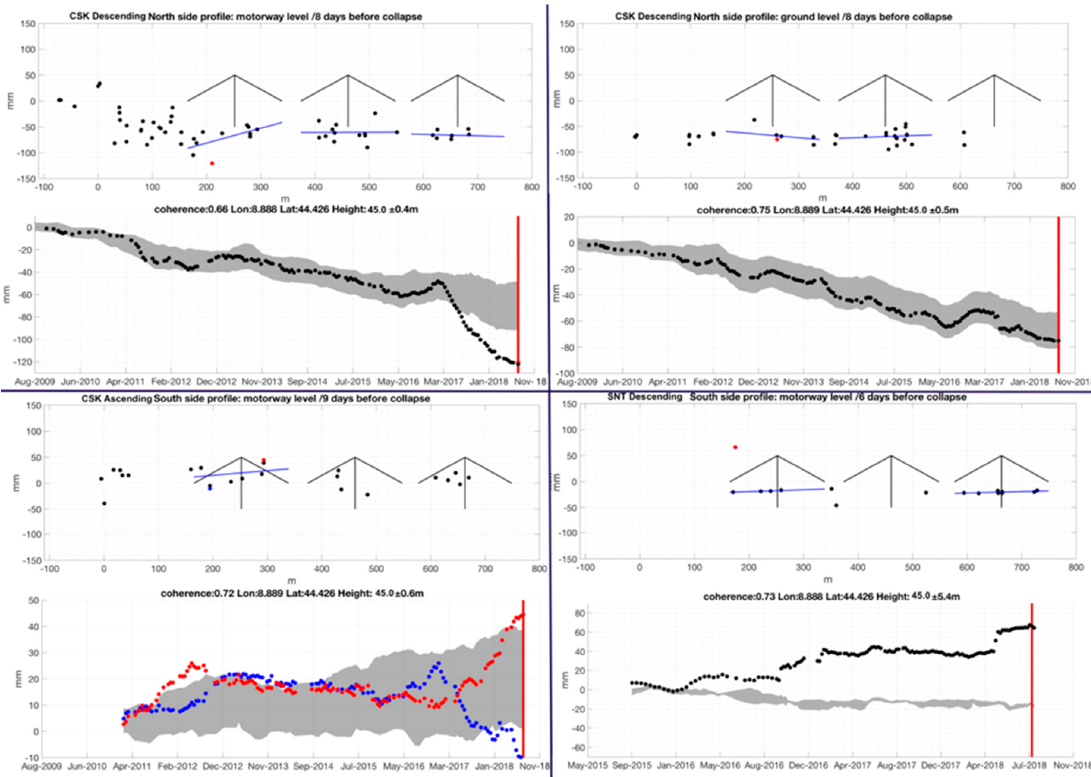
Figure 5. Time-series deformation for the ascending/descending line of sight (LOS) of the CSK/Sentinel- 1A/B satellites. Animated time-series of bridge deformation are shown in Movies 1–8.